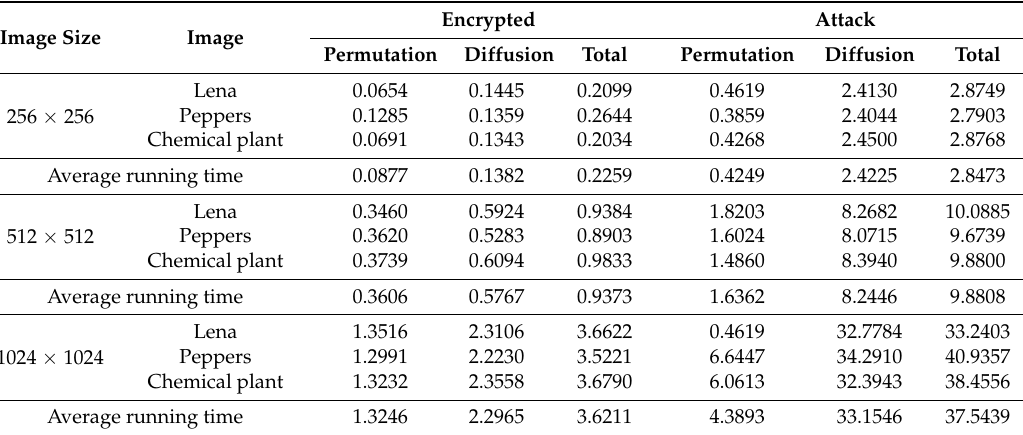
Table 1. Execution time